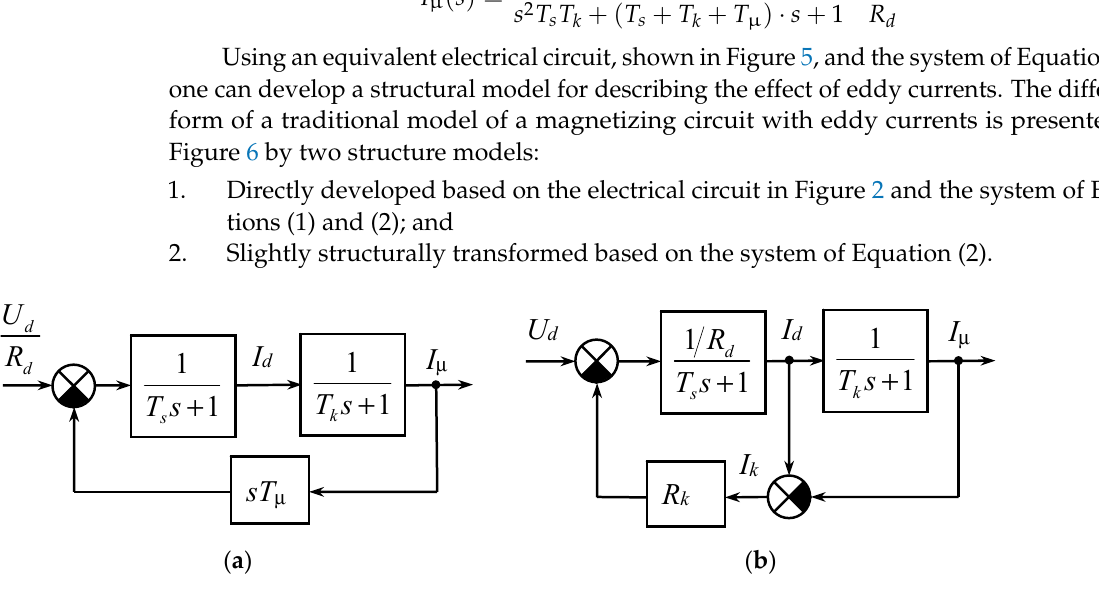
Figure 6. Structural model for the excitation circuit of a DC machine with eddy currents, based on the system of Equation (2). ( a ) structural model (first step); ( b ) structural model after